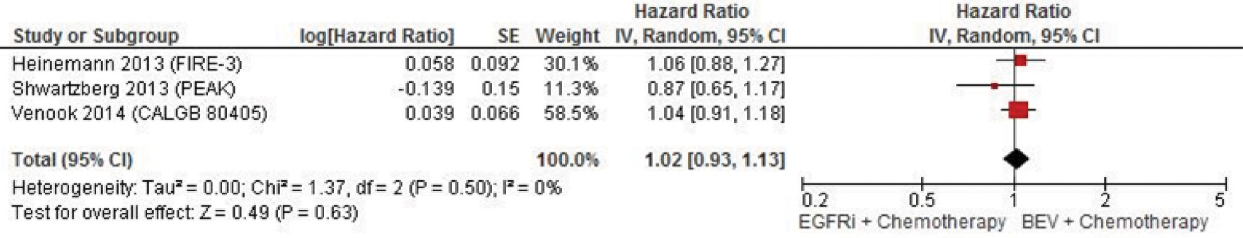
Fig 3. Forest plots of hazard ratios comparing progression-free survival of EGFRis with chemotherapy versus BEV with chemotherapy.